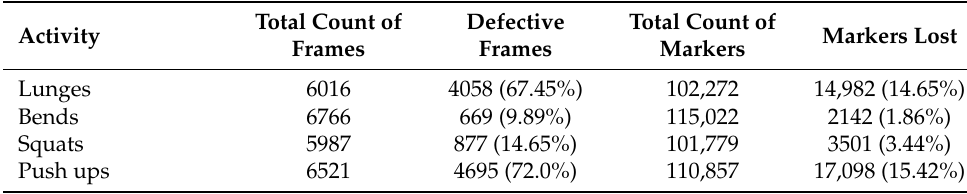
Table 3. Overview of defective frames of camera system caused by loosing markers during multiple physical